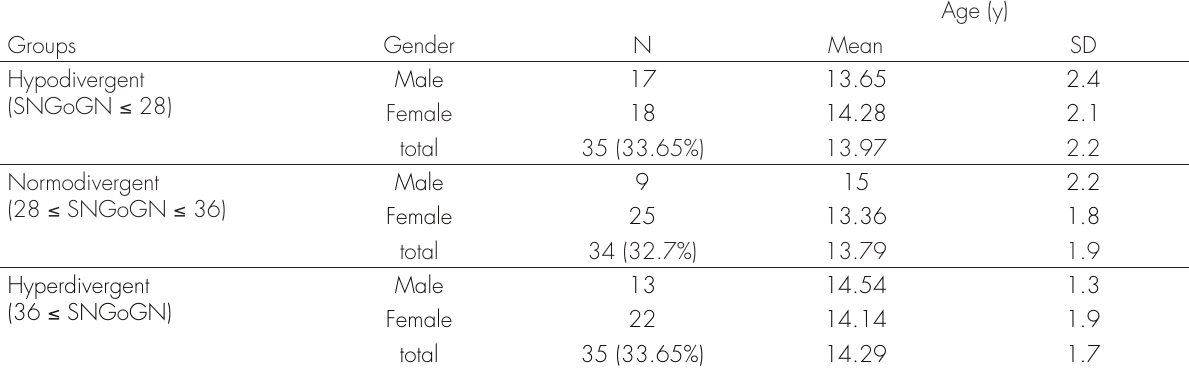
Table I. Age and gender distributions of the study